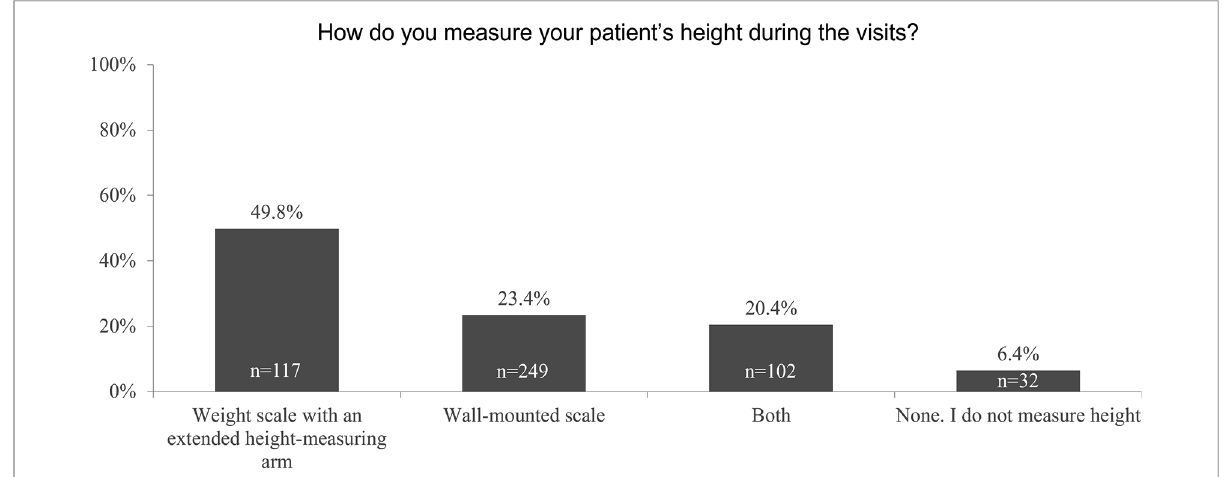
FIGURE 2 Survey response “ How do you measure your patient ’ s height? ”